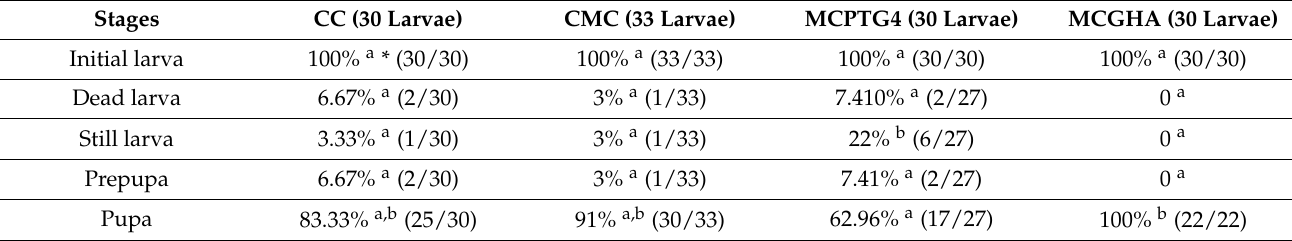
Table 1. Effects of feeding on Beauveria bassiana -treated plants on the developmental stages of Spodoptera frugiperda.